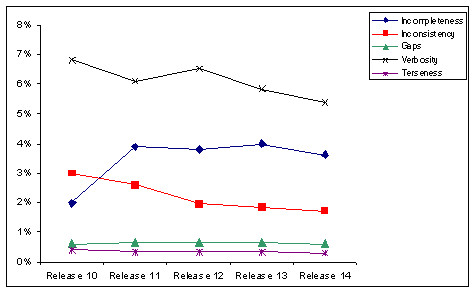
Plot of the properties over Reactome releases. The figure shows the change in the percentage of reactions that were responsible for the violation of each particular property from releases 10 to 14.